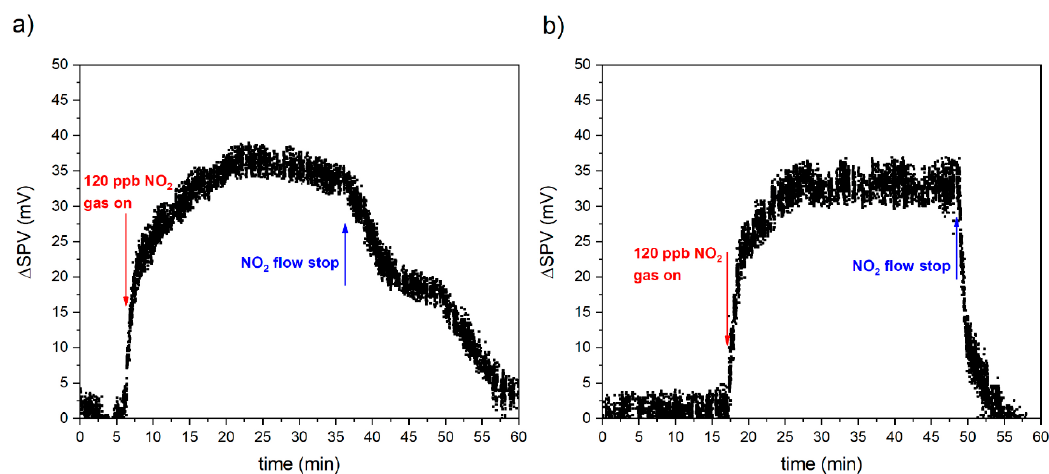
Figure 3. The variation of amplitude of surface photovoltage (SPV) for RGVO SnO x nanolayers after exposure to 120 ppb NO 2 . The plot presented in ( a ) corresponds to the initial measurements, whereas ( b ) is related to the experiments repeated after 6 days .